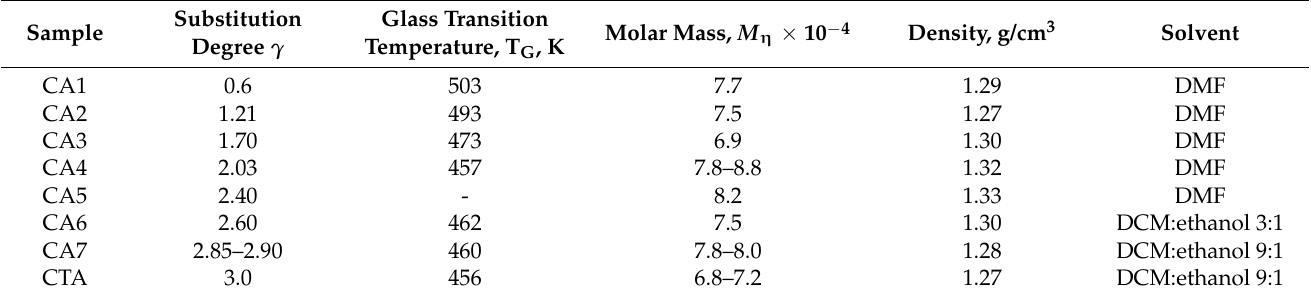
Table 1. Properties of the study